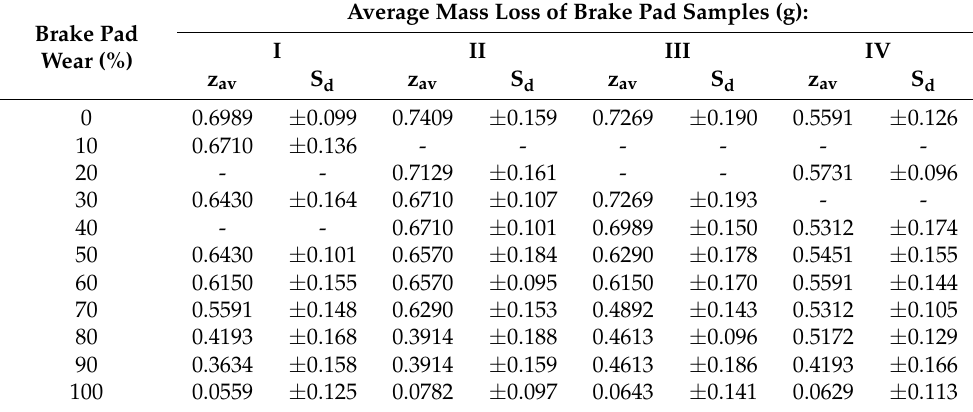
Table 7. Mass loss according to the results of the conducted friction tests.